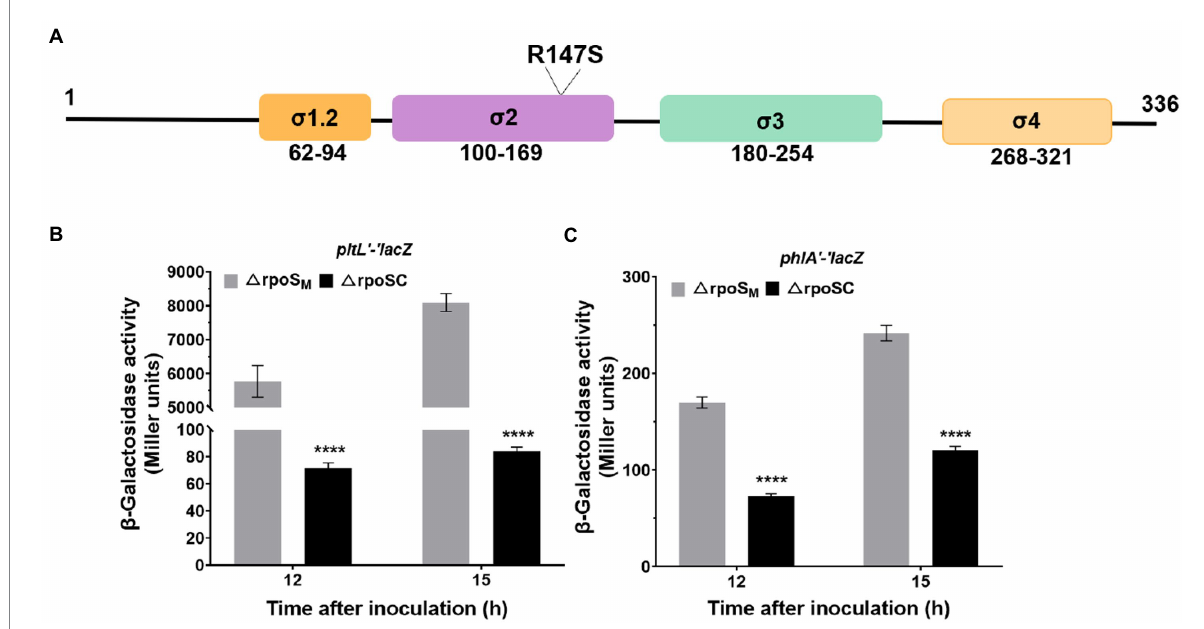
FIGURE 7 Effect of Δ rpoS on the expression of phlA ′ - ′ lacZ and pltL ′ - ′ lacZ . (A) Schematic representation of the four regions of the RpoS protein and location of the R147 mutation in region 2, which binds to the-10 promoter of a target gene. (B,C) Differences in β -galactosidase expression in two reporter vectors, 6,013-pltL and 6,013-phlA, were determined between P. protegens FD6 derivatives grown for 12 h and 15 h in LB at 28 ° C. The plasmid pBBR1MCS-2, carrying the rpoS or rpoS R147S genes, was used in complementation experiments. The experiment was performed in three biological replicates. Error bars indicate ±standard deviation. **** p < 0.0001.